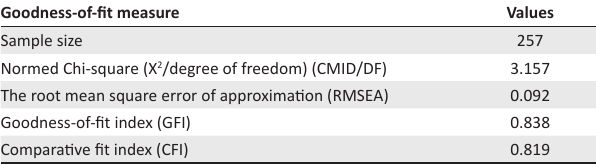
TABLE 7: Goodness-of-fit indices for the structural strategic thinking model.